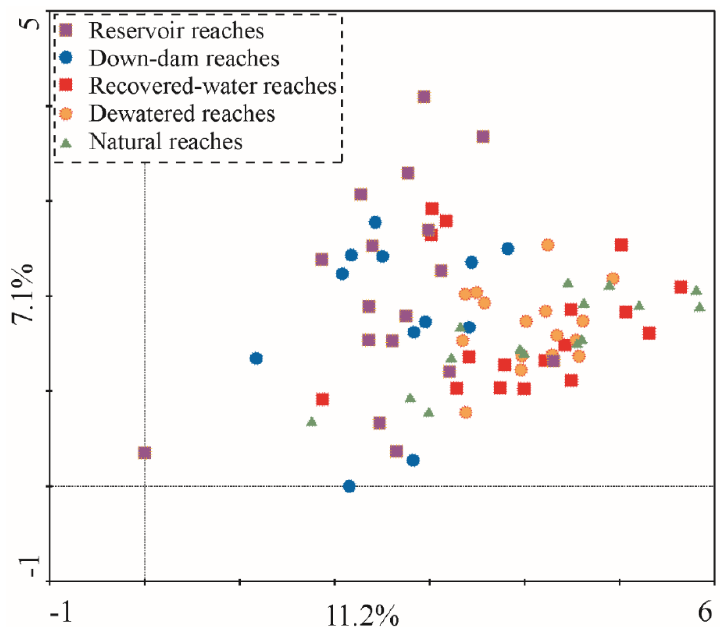
Figure 5. Ordination diagram of all sample sites through a detrended correspondence analysis (DCA) sequencing analysis.